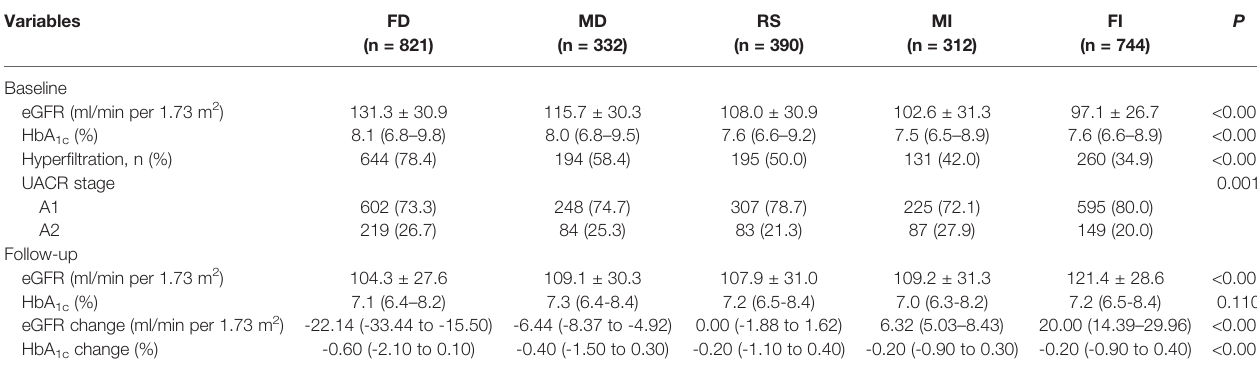
TABLE 2 | Characteristics among subjects strati fi ed by eGFR changes. Variables FD MD